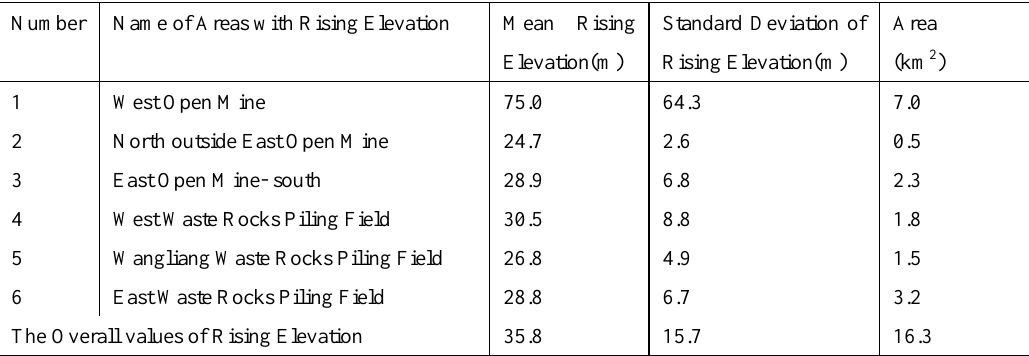
Table 5 Results of the deformation areas with rising elevation using ZY-3 DEM in 2015 and ASTER GDEM.